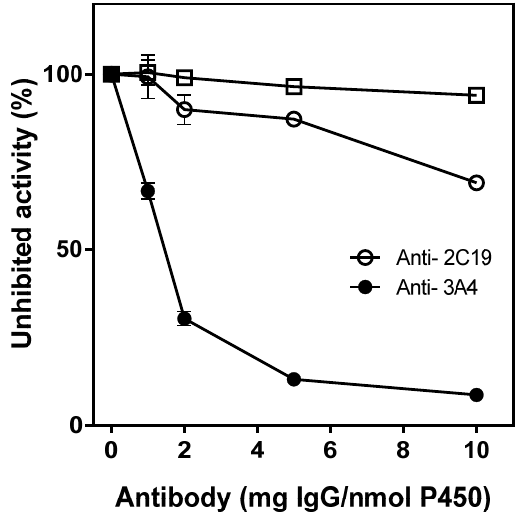
Figure 5. Immunoinhibition of antibodies on phloretin 3- hydroxylation activity catalyzed by HLMs. The e ff ects of anti-CYP3A4 ( • ), anti-CYP2C19 ( ), and preimmune IgG ( (cid:3) ) on phloretin 3- hydroxylation (cid:35) activity in HLMs were measured. Values represent the means ± SD of three